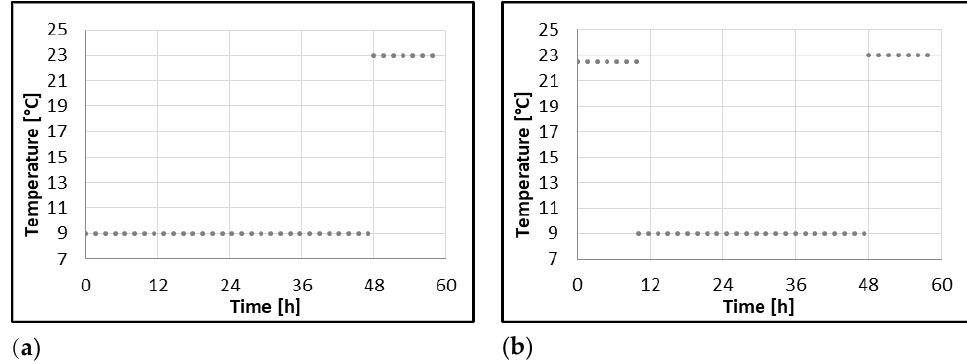
Figure 1. Temperature profiles of incubations of soft drinks containing goji berries: ( a ) Profile I 9 °C – 23 °C for samples refrigerated immediately after inoculation, ( b ) Profile II 22.5 ℃–9 ℃–23 ℃ for samples refrigerated 10 h after inoculation.